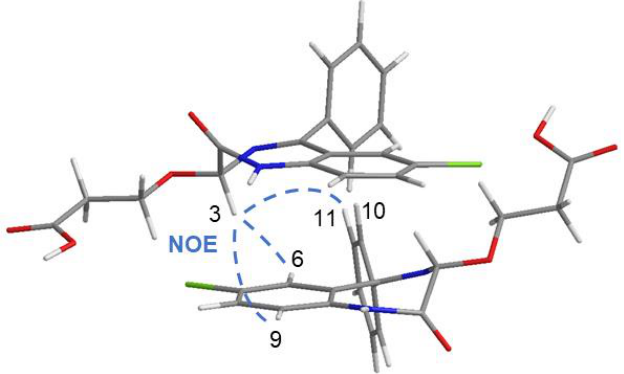
Figure 3. 3D representation of OXEMIS dimer as obtained from NMR data.